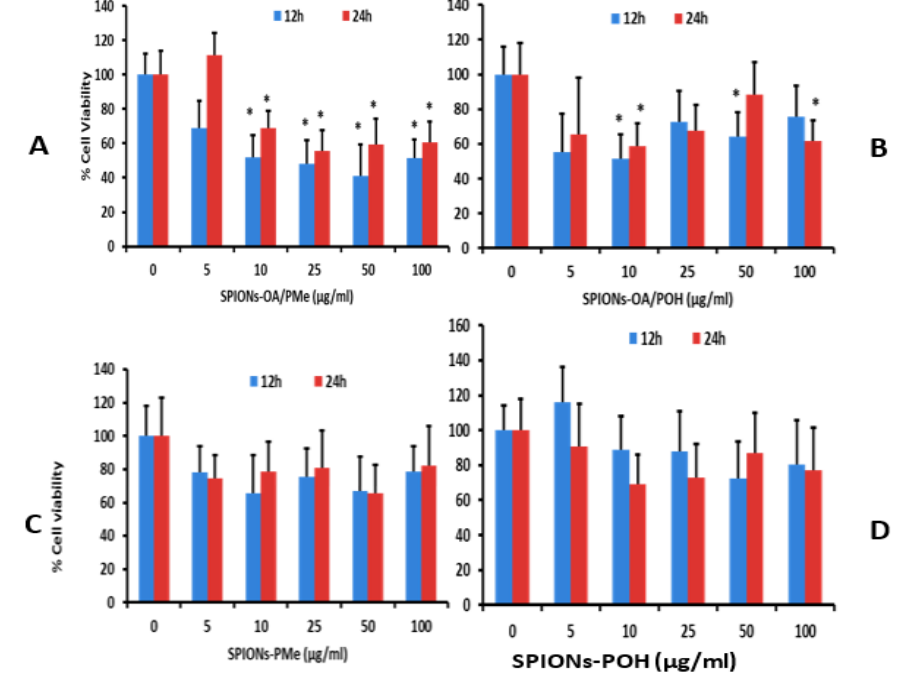
Figure 3. Brain endothelial cell viability after 12 and 24 h treatment with water-dispersible SPIONs at various concentrations (μg/mL): ( A ) SPIONs-OA/PMe; ( B ) SPIONs-OA/POH; ( C ) SPIONs-PMe; ( D ) SPIONs-POH.